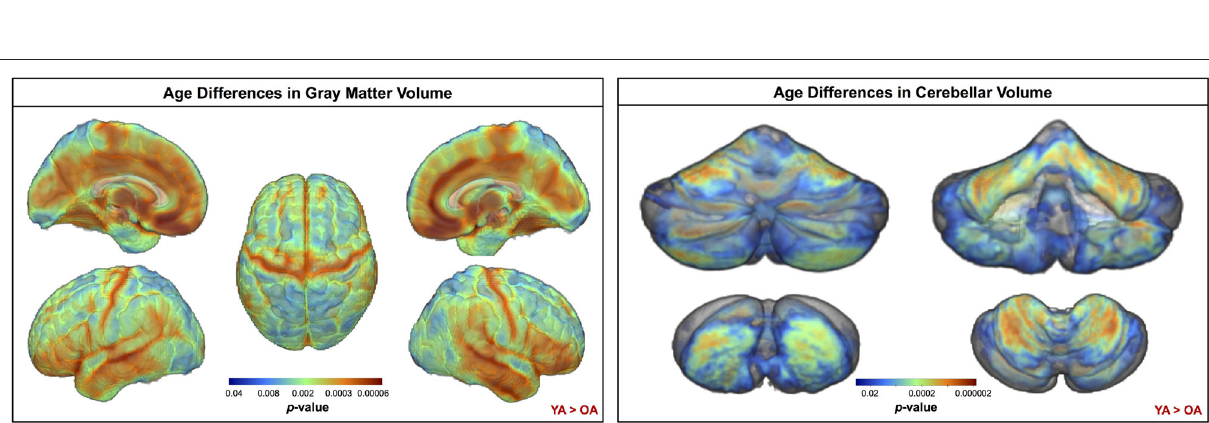
Frontiers in Aging Neuroscience |